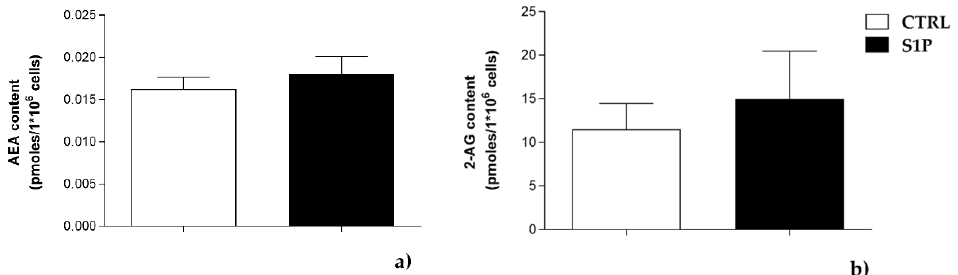
Figure 4. Effect of 1 μ M S1P on endogenous levels of AEA ( a ) and 2-AG ( b ), measured by using liquid chromatographic–mass spectrometry (LC-MS) analysis. The values represent the means ± SEM of three independent experiments ( n = 3). Statistical analysis was performed by ONE-WAY ANOVA test, followed by Bonferroni post hoc test.